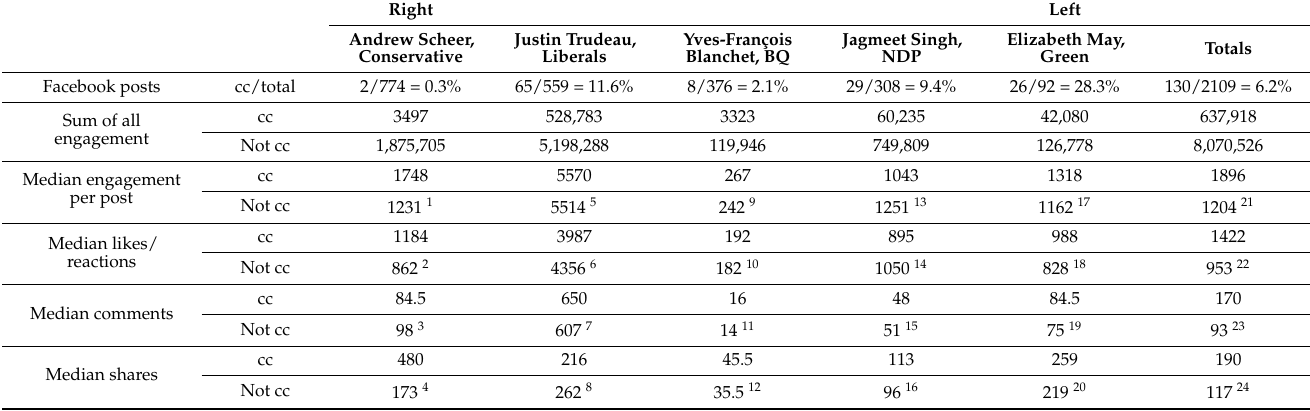
Table 4. Engagement with Social Media